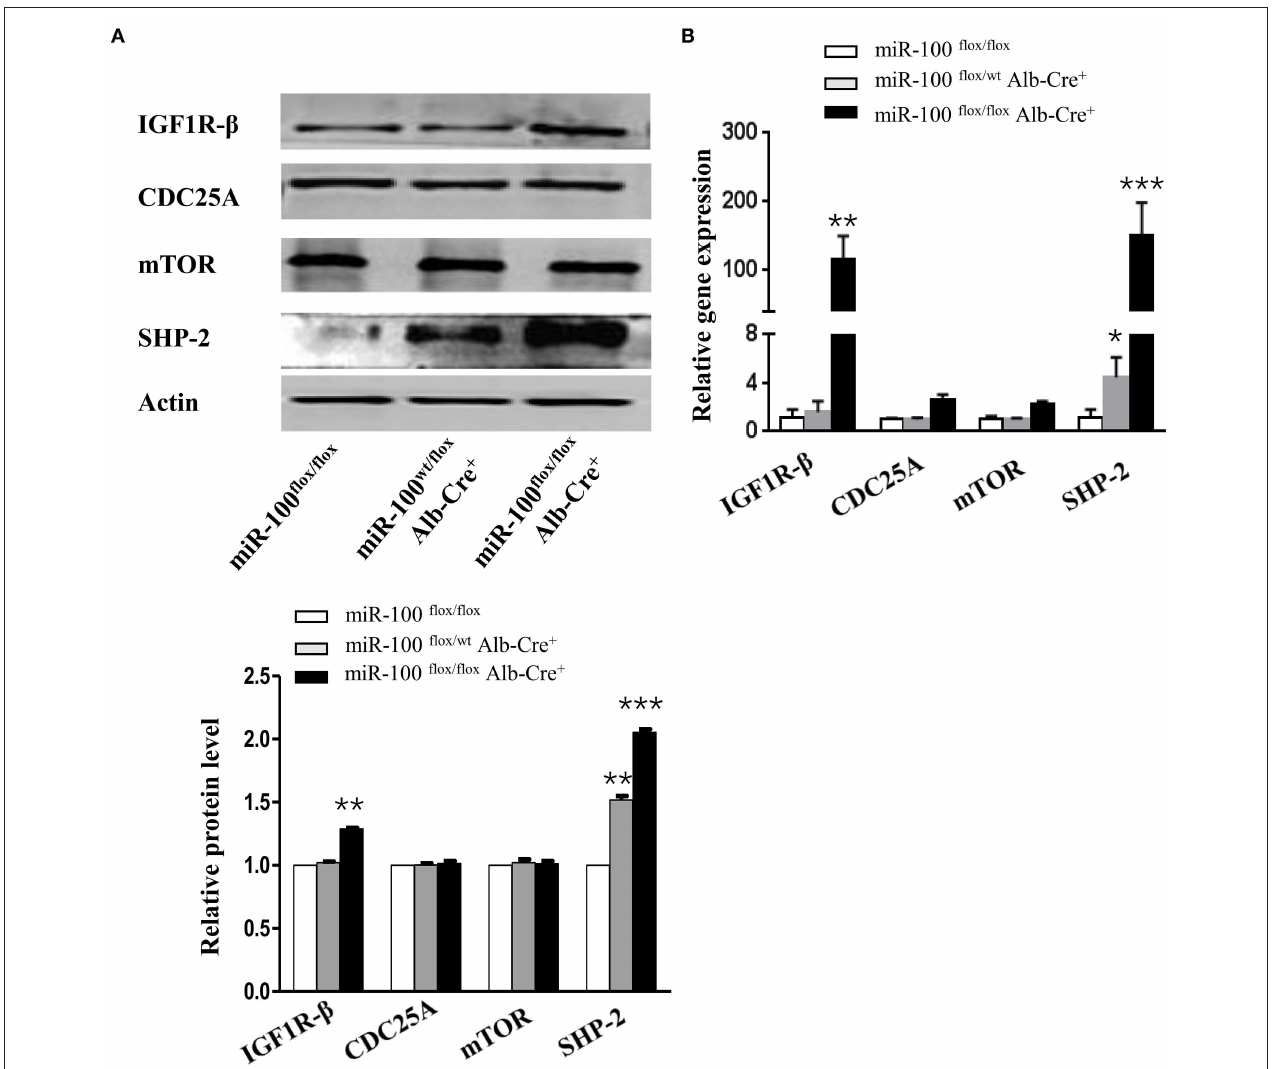
FIGURE 6 | Increased expression of IGF1R- β and SHP-2 in miR-100-knockout livers. Western blot analysis (A) and quantitative RT-PCR analysis (B) of the expression of miR-100 target genes and SHP-2 in the livers from miR-100 flox / flox Alb-Cre + and control littermates. Anti- β -actin was used as a loading control. Data are from three independent experiments with similar results. * P < 0.05, ** P < 0.01, *** P < 0.001 (Student’s unpaired t test,